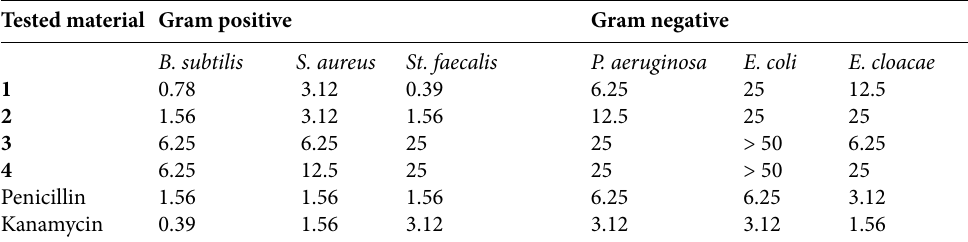
Table 4. MICs (μg mL –1 ) of the compounds and related